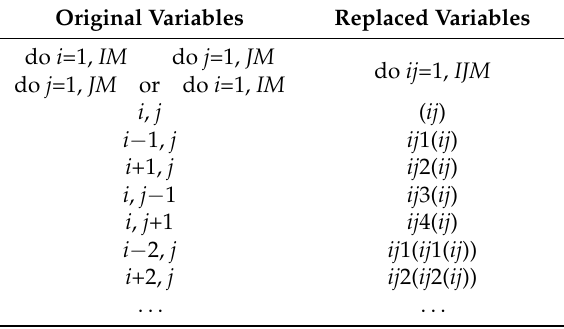
Table 1. Variables and statements are being replaced in models before and after being one-dimensioned ( Fortran